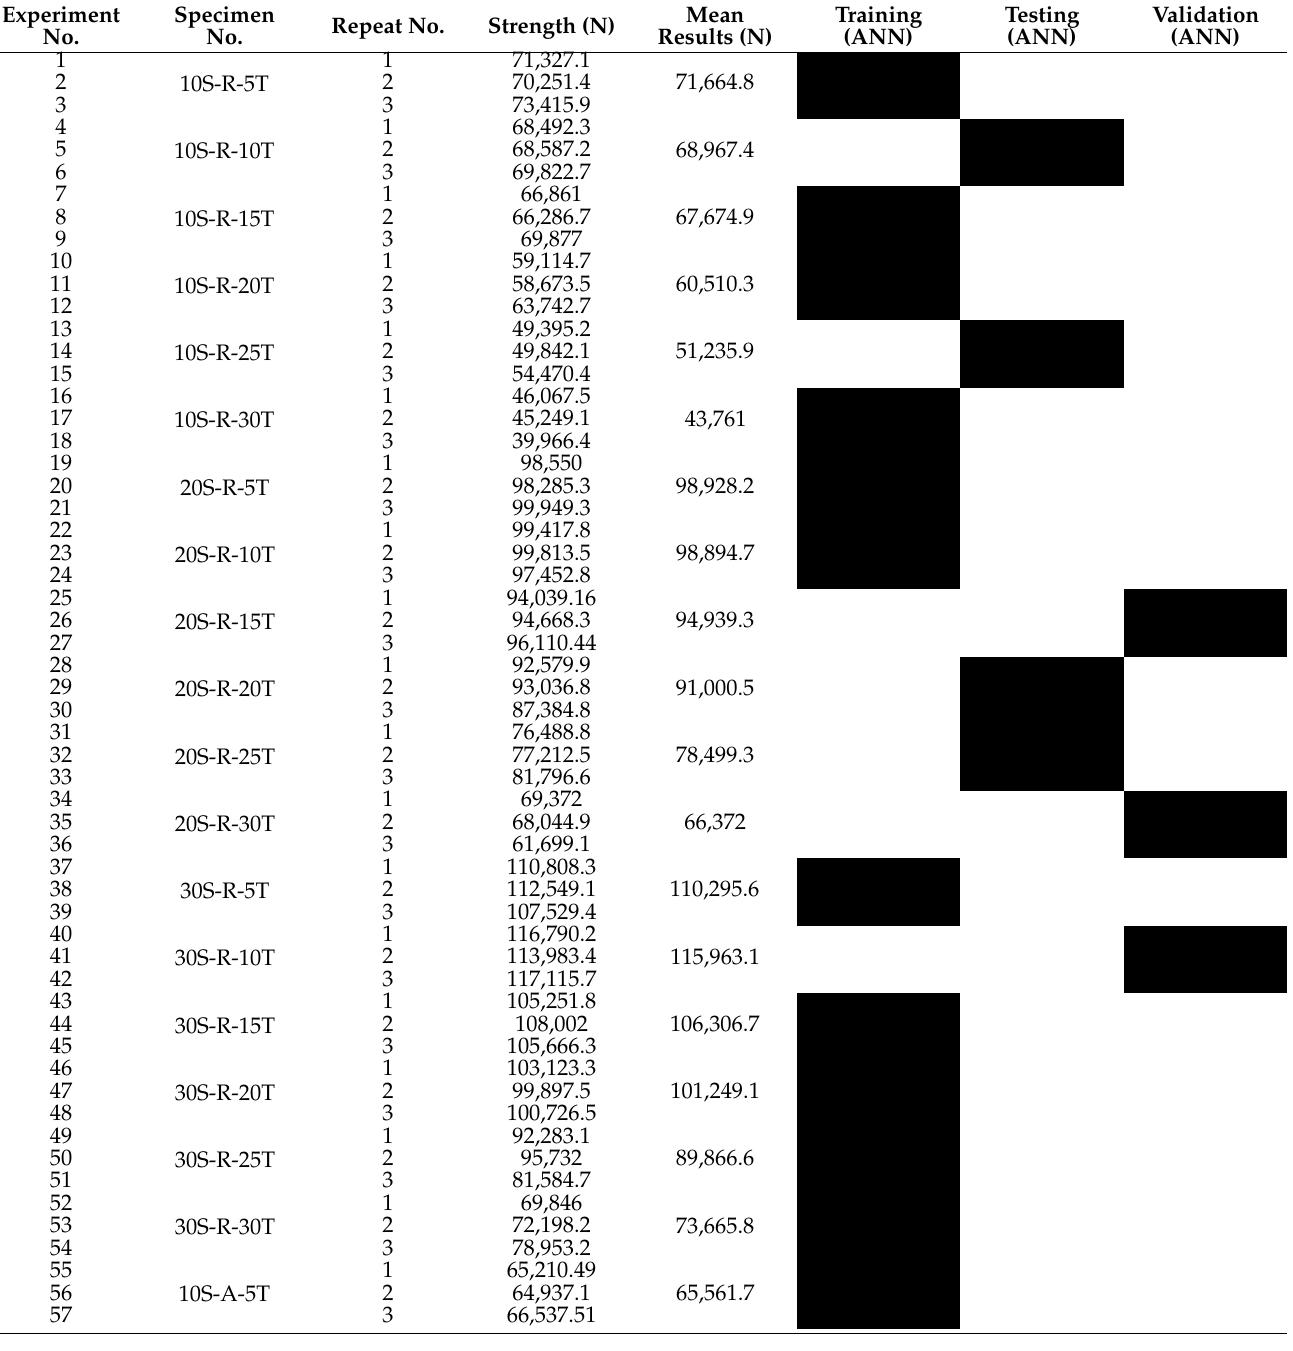
Table A1. Results of the uniaxial mechanical test under compression load and the details of data used in each stage of the neural network